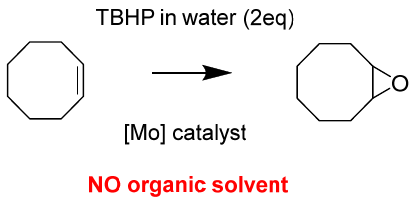
Figure 1. Organic solvent-free epoxidation of cyclo-octene.